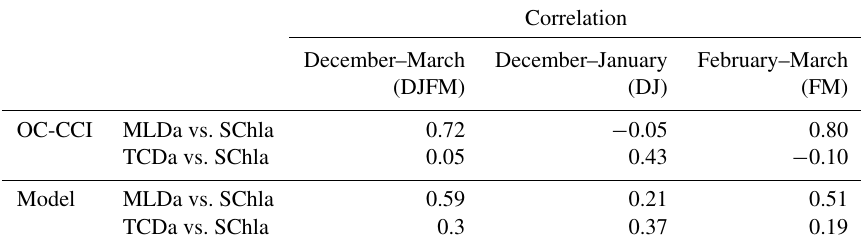
Table 3. Correlation between interannual SChl anomalies and interannual MLD and TCD anomalies averaged over the NAS box for December–March, December–January, and February–March. Bold typeface indicates correlations which are statistically different from zero at the 90% confidence level.